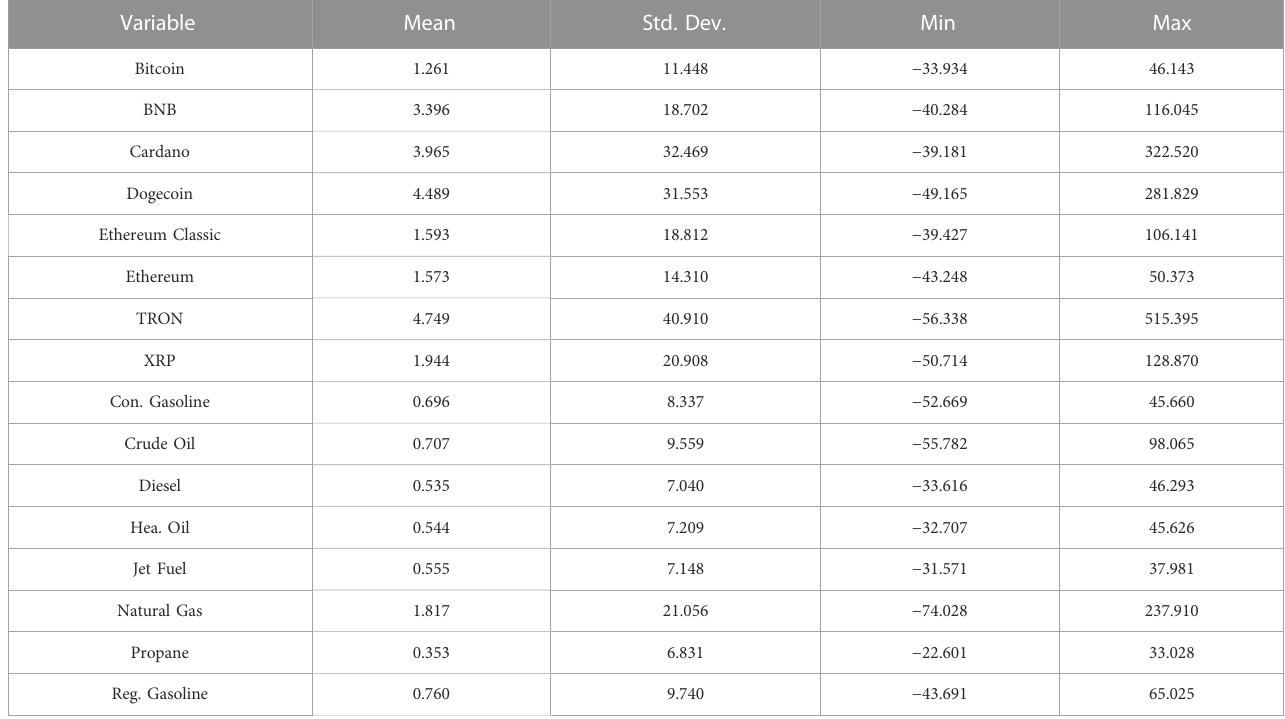
TABLE 1 Statistics on the change rates of cryptocurrencies and energies (%).